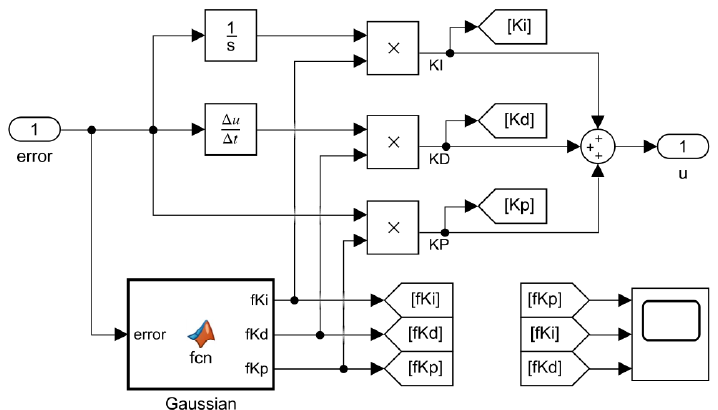
Figure 6. Simulink model of the GAPID